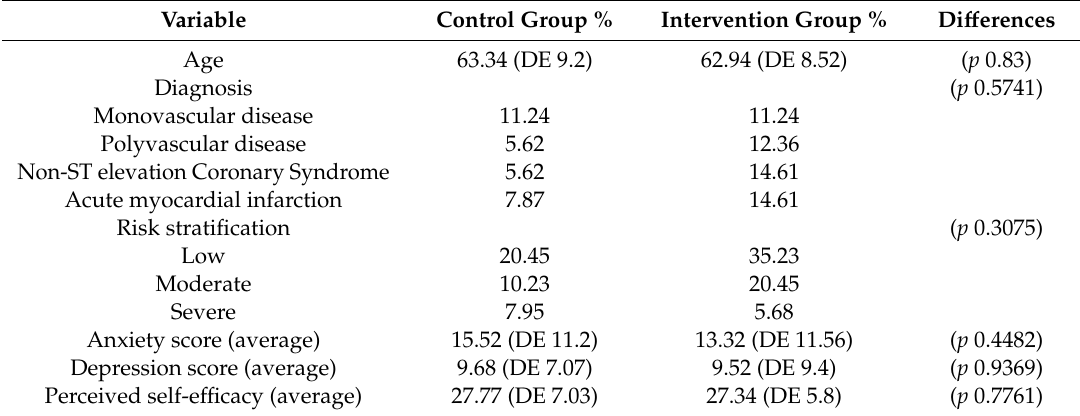
Table 1. Baseline data for the variables. No significant di ff erences between